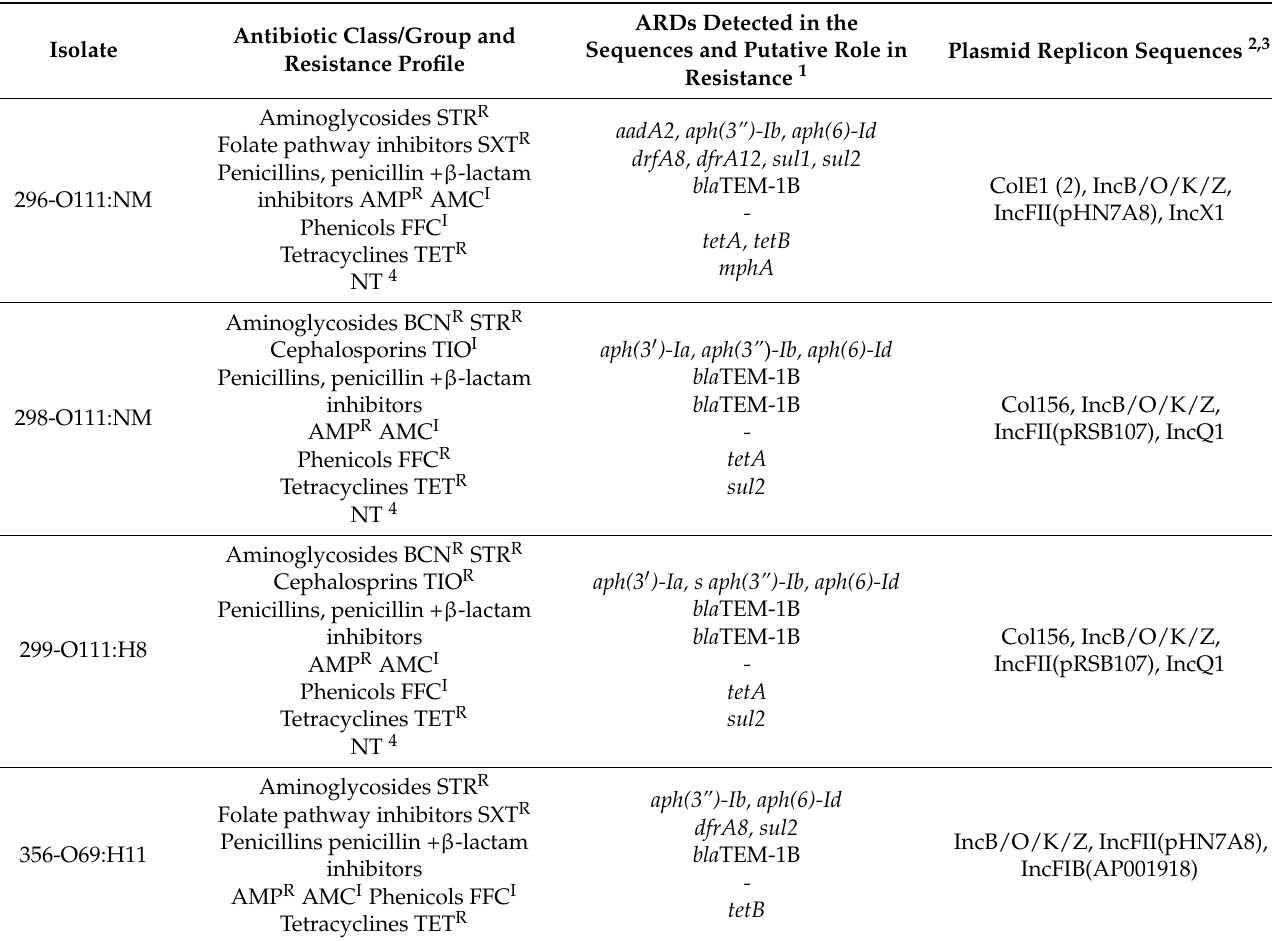
Table 3. Acquired resistance determinants (ARDs) and plasmid replicon sequences detected in whole-genome sequences of eight multidrug resistant (MDR) STEC isolates from surface water and